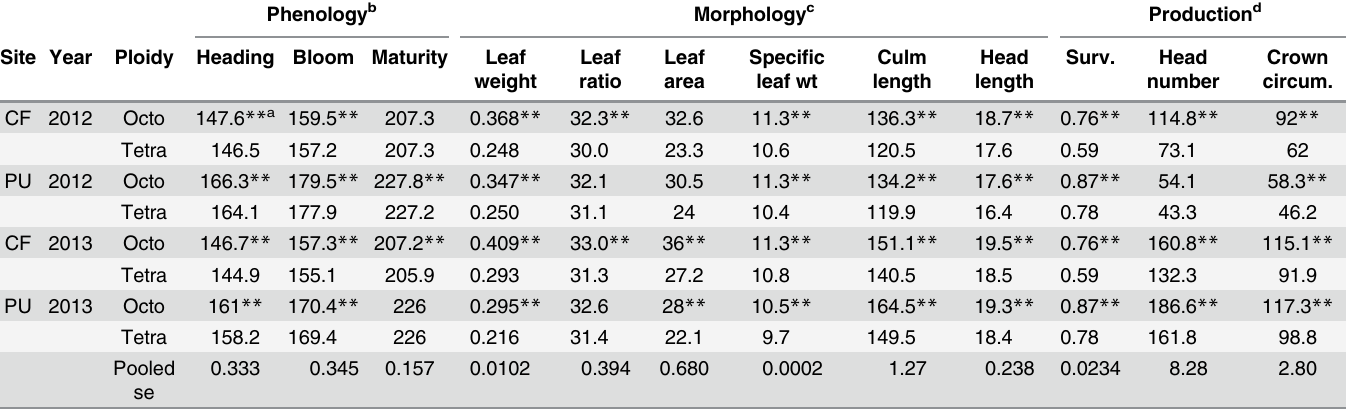
Table 3. Mean comparisons between wild octoploid (n = 57) and tetraploid (n = 52) basin wildrye among years and common gardens sites at Cen- tral Ferry (CF) and Pullman (PU),